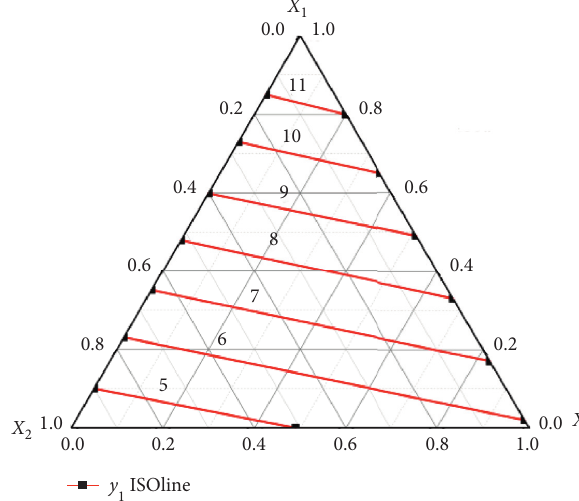
Figure 4: Isogram of compressive strength y 1 regression equation. Table 10: Regression analysis of peak displacement of raw soil mixed with cement and gravel.